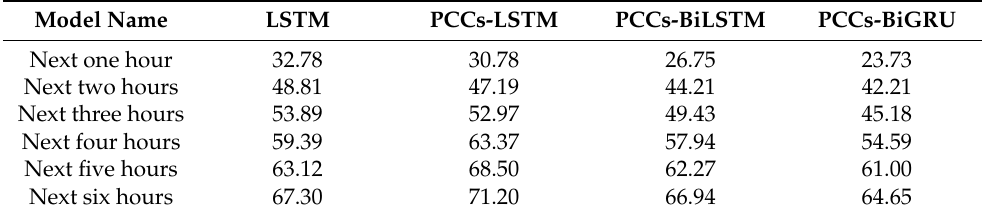
Table 9. The RMSE of PM 10 concentration prediction in the next six hours. Model Name